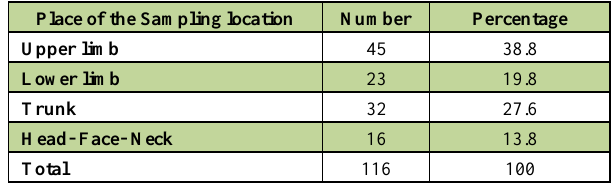
Table 4. Frequency Distribution of the Place of the Sampling Location of Patients Admitted to ICU Burn Center of Rasht City.